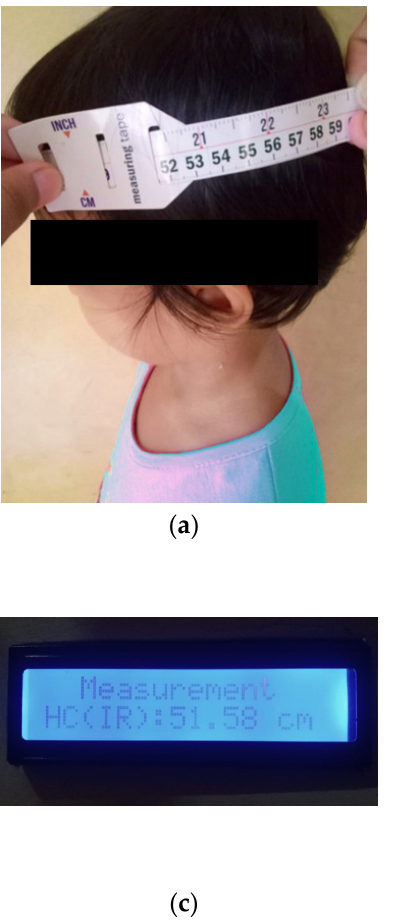
Table 4. Comparison between head circumference measurement results using conventional tools (measuring tape) and a prototype (IR sensor).